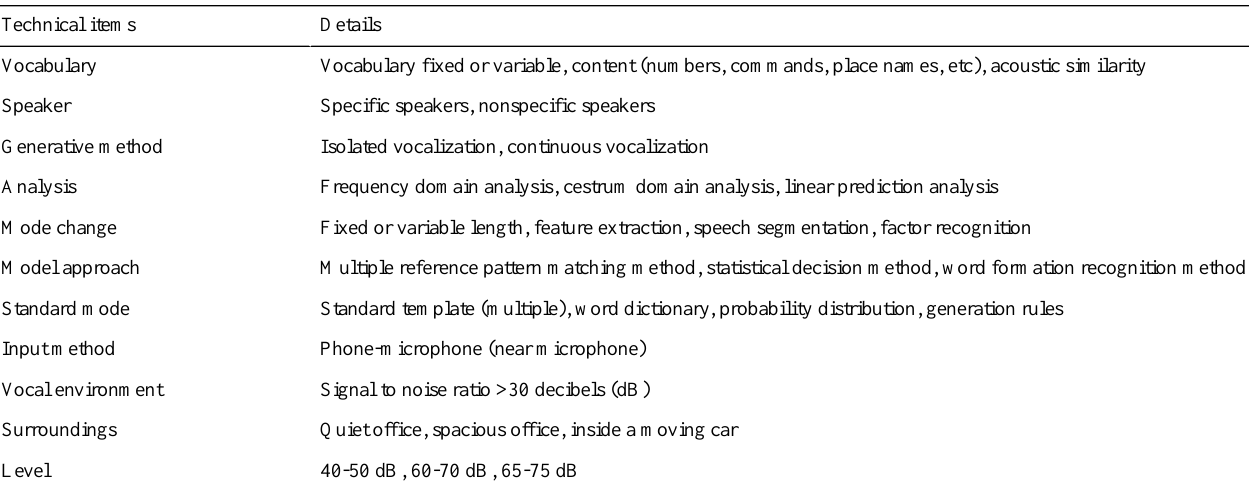
Table 1. Main technical items of the isolated word speech recognition